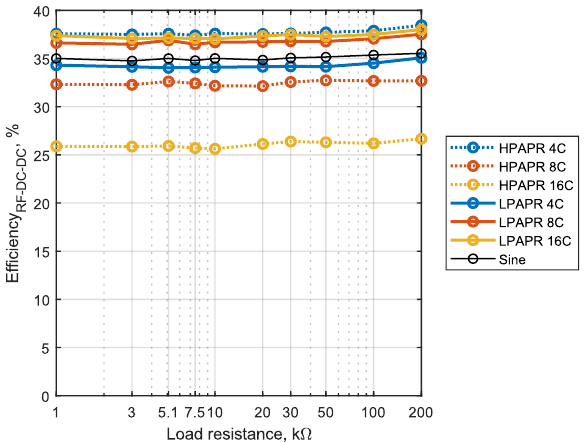
Fig. 11. RF-DC conversion efficiency of the harvesting device for different signal waveforms and different loads at the DC-DC converter output.